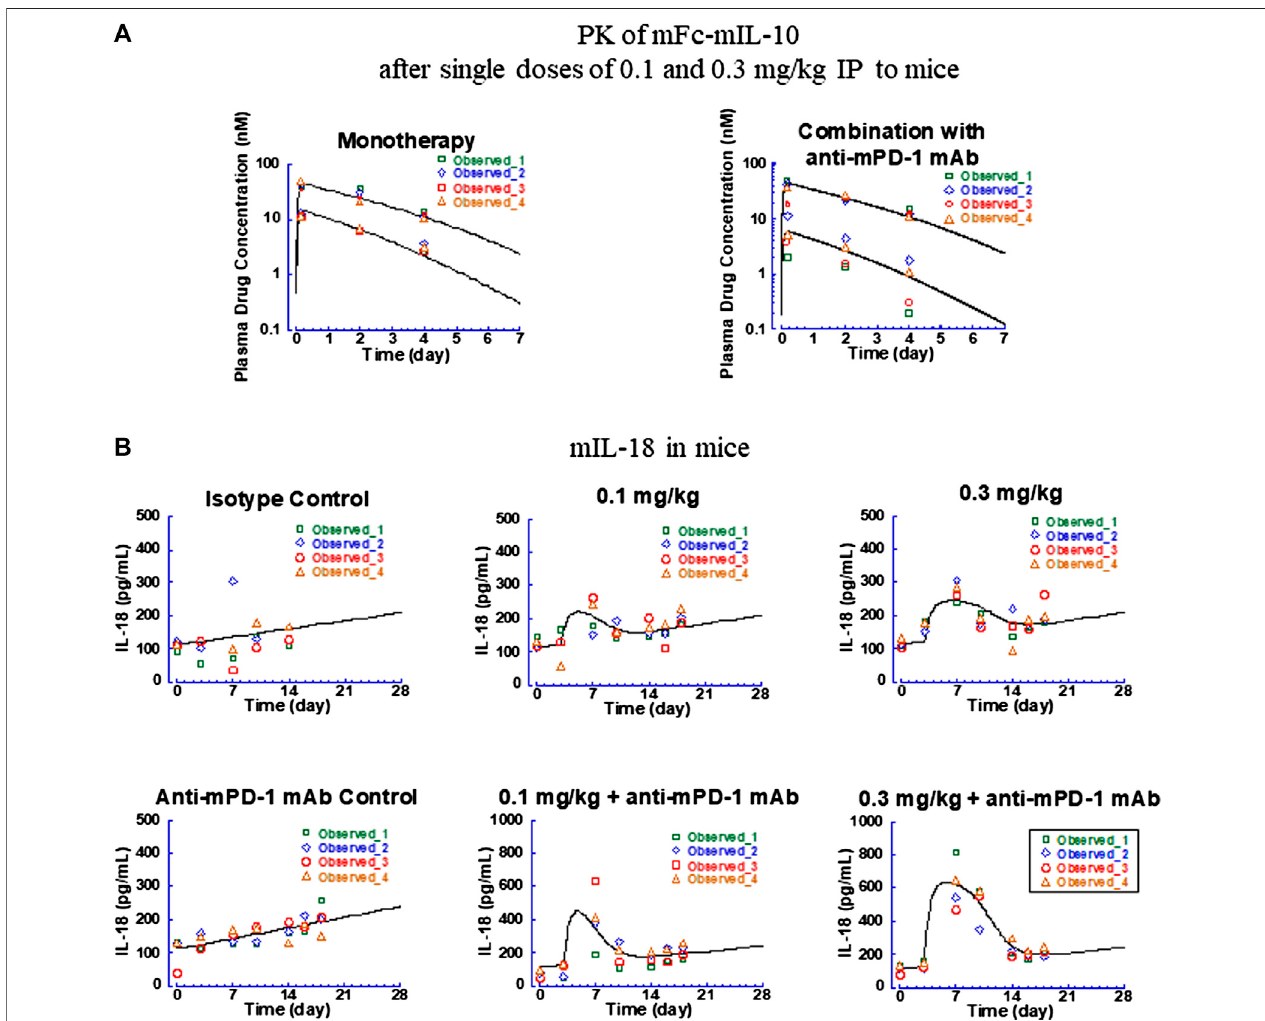
FIGURE 3 | Fitted versus observed pharmacokinetic and IL-18 induction data in CT26 syngeneic tumor-bearing mice after intraperitoneal administration of mFc- mIL-10 at 0.1 and 0.3 mg/kg either as a single agent or in combination with a mouse anti-mouse programmed death-1 monoclonal antibody that was dosed intraperitoneally at 10 mg/kg every4 days for3doses. (A) Pharmacokineticpro fi les ofmFc-mIL-10; (B) Time-coursedata ofmouse IL-18induction.Linesrepresentthe model- fi tted curves; symbols show individual observed data ( n = 4 per time point). When data points are less than the number indicated, they are below the lower limit of quantitation for pharmacokinetic data or unavailable for mouse IL-18